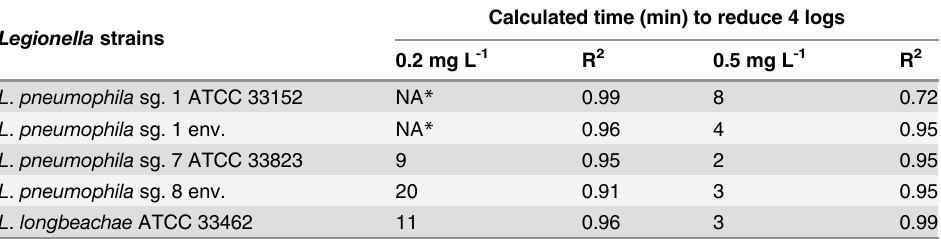
Table 1. Calculated time for a 4-log reduction of five Legionella strains at 0.2 mg L -1 and 0.5 mg L -1 of free chlorine. Inactivation kinetics adjusted to a biphasic decay model ( * ) and to a first-order (straight line) model. R 2 values showed the robustness of the model. NA (not achieved).